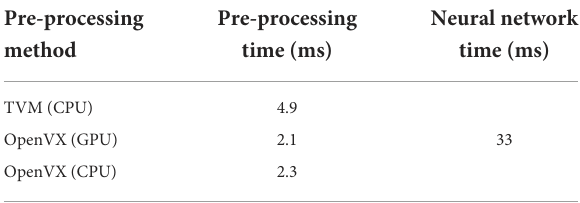
TABLE 3 Execution times for YOLOv3-tiny object detection neural